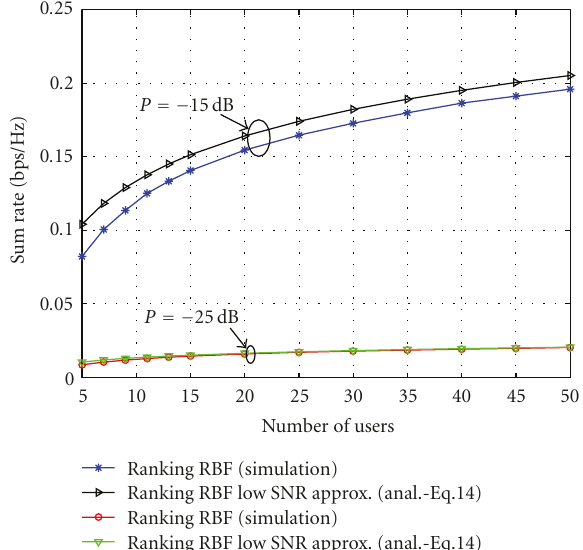
Figure 1: Sum rate performance comparison of analytic high SNR approximate solution (13) for RBF ( M = 4beams) using ranking- based CSIT as user selection metric to simulated results using Monte Carlo.